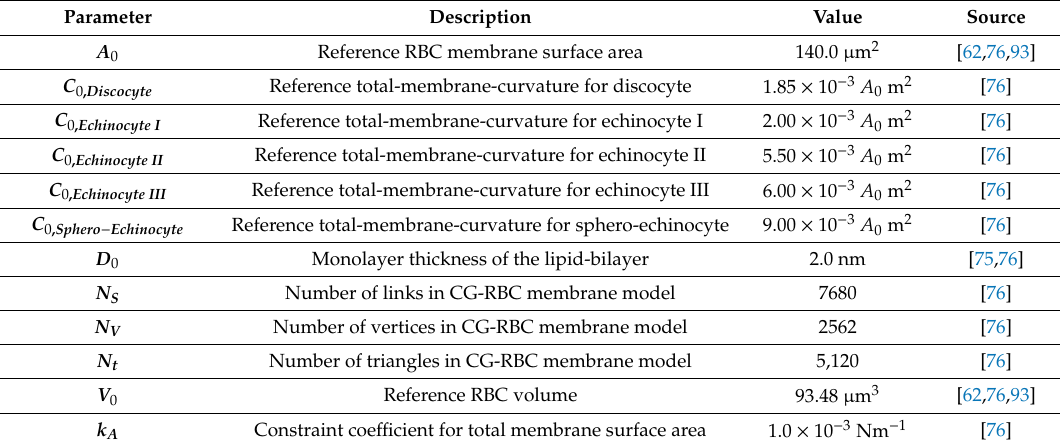
Table A1. The key parameters values used to model the discocyte, echinocyte I, echinocyte II, echinocyte III and sphero-echinocyte RBC